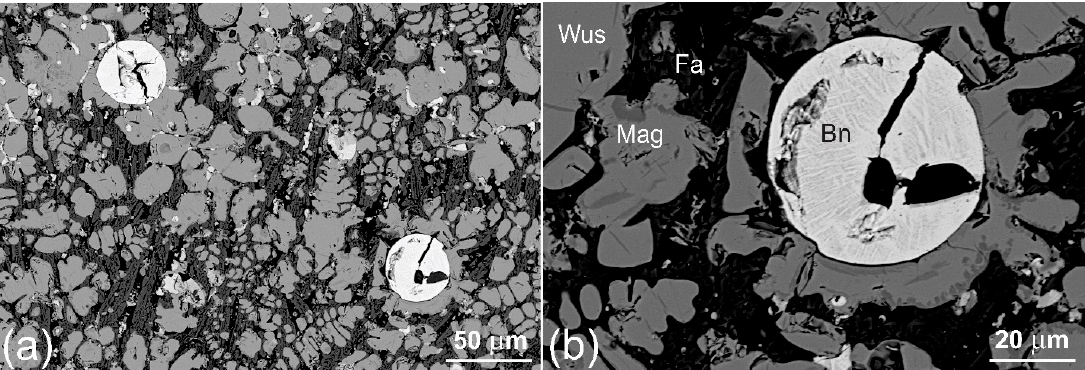
Figure 10. SEM-BSE images of a sample of magnetic slag (Figure 2a). ( a ) Overview and ( b ) enlarged area. Cu-Fe sulfide nodule (bright) composed largely of bornite (Bn). Skeletal crystals are Fe-oxides, mainly wüstite (Wus, brighter grey) and some magnetite (darker grey). Matrix is prismatic fayalite (Fe-olivine, Fa).